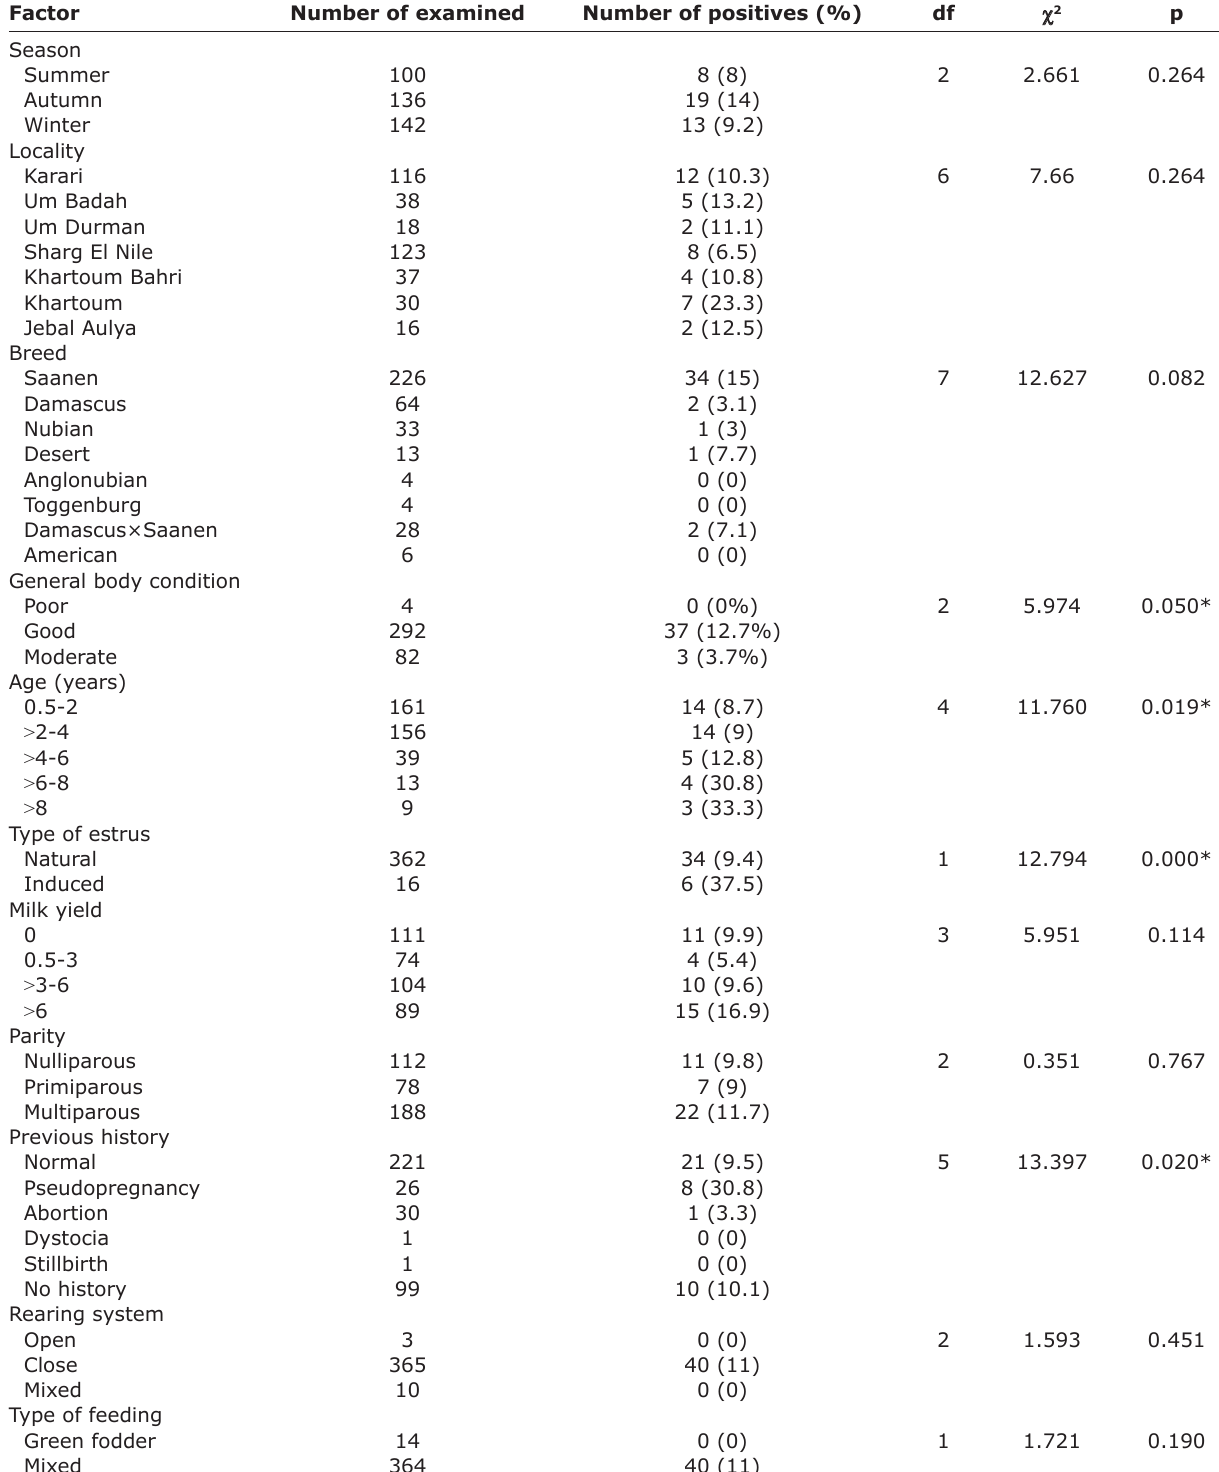
Table-1: Univariate analysis of the association of potential risk factors with pseudopregnancy in goats using the Chi-square test.